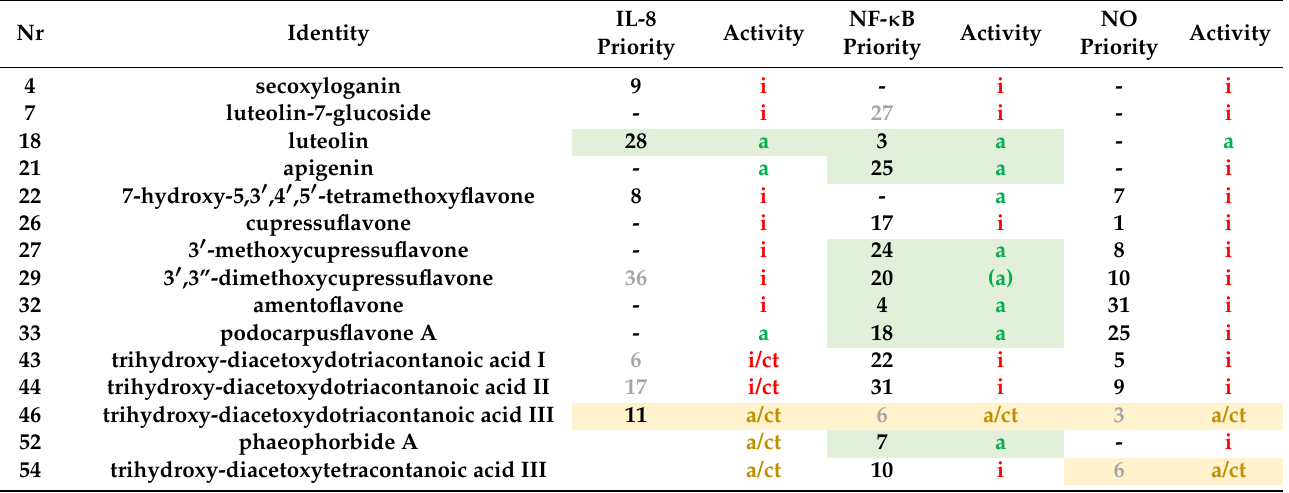
Table 6. Comparison of experimentally determined in vitro anti-inflammatory activities of selected OPLS-DA candidate compounds with priorities deduced from OPLS-DA model; green fields indicate correctly predicted active compounds, and yellow fields indicate correctly predicted active com- pounds with negative impact on cell viability; Compound numbers, identification and priorities from OPLS-DA models; see Table 1. Numbers written in gray indicate low reliability (jackknife-based confidence interval including 0); activities determined in cellular inflammation assays; see Table 5.